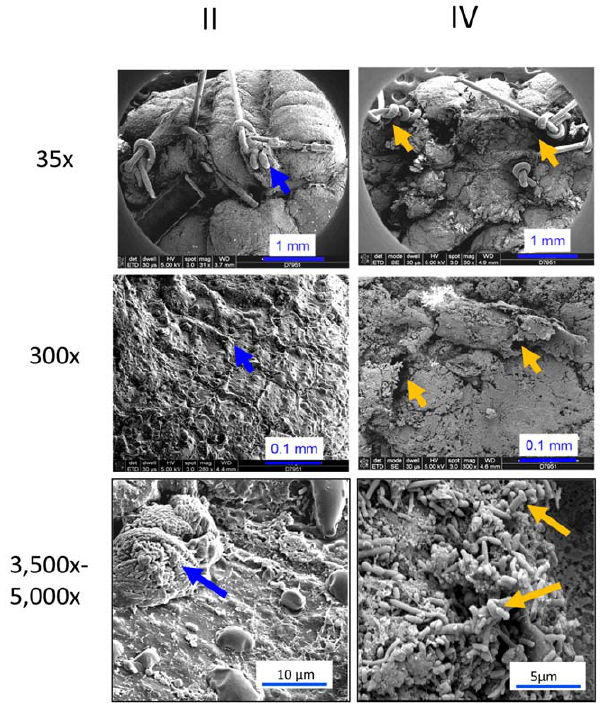
Figure 2. Scanning electron microscopy (SEM) images of anastomosis tissues. Blue arrows indicate healed anastomosis (30x), intact intestinal epithelium (300x), and macrophages on epithelial surface (3,500x) in group II. Orange arrows indicate discontinuity near or at the anastomosis (30x), disrupted intestinal epithelium (300x), and a high degree of bacterial colonization/adherence at the edge of non- healed anastomoses (5,000x). 50 images from each group of 5 mice were obtained, and representative images are displayed.